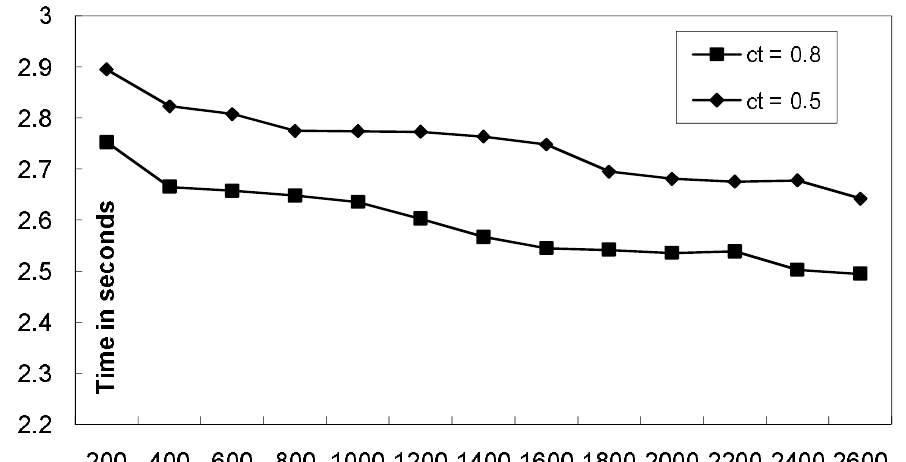
Figure 6. The execution times under different correlation block sizes.